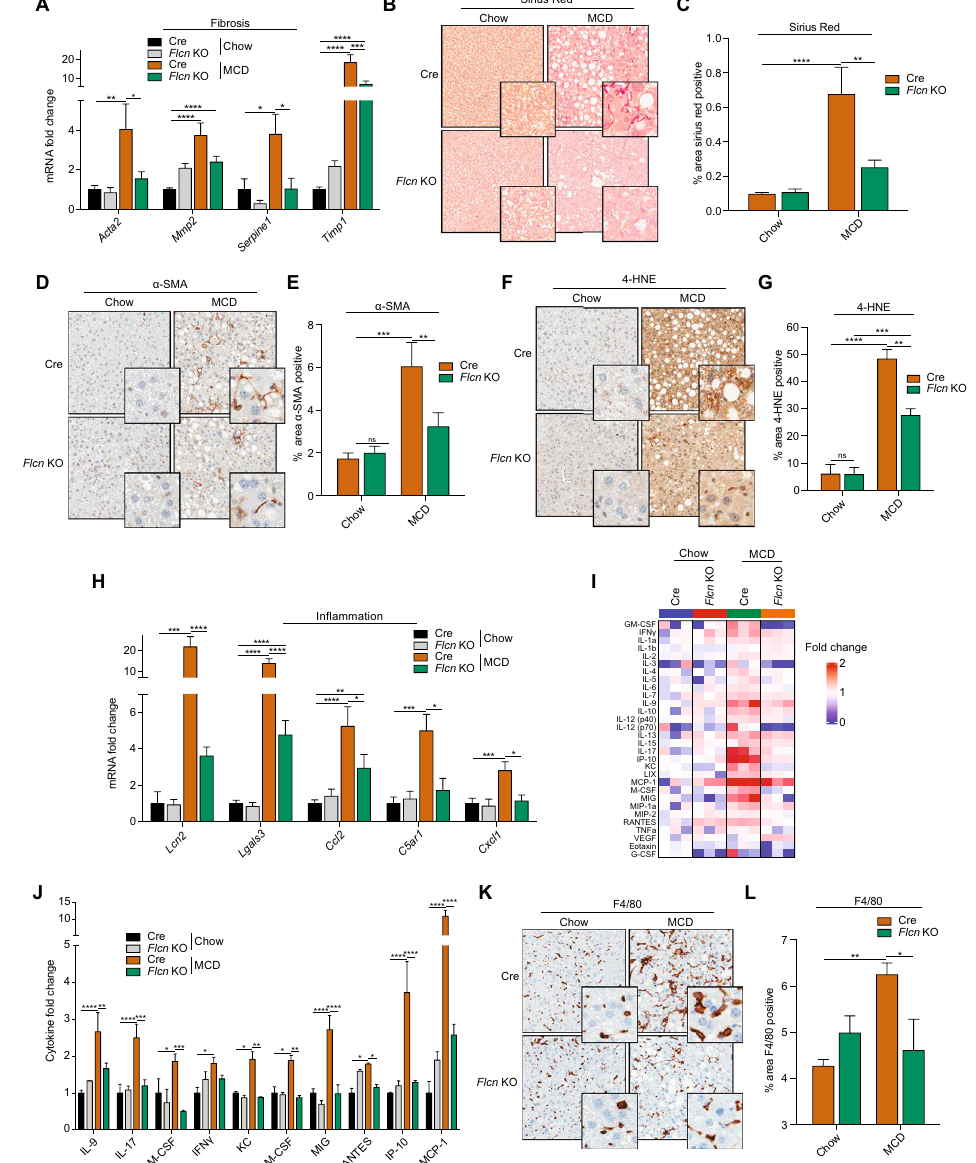
Figure 3. Flcn loss reduces MCD diet-induced fibrosis and inflammation. ( A ) Relative quantitative real ‐ time PCR analysis of fibrosis-related genes mRNA transcript levels in livers of mice fed either on chow or methionine/ choline deficient diet (MCD) over a period of 6 weeks (mean ± SEM of the RNA fold change of indicated mRNAs; two-way ANOVA, *P < 0.05, **P < 0.01, ***P < 0.001, ****P < 0.0001; n = 8 mice per condition). ( B ) Sirius red staining in liver sections of mice fed as described in ( A ). Images are representative of 6 mice per condition. ( C ) Quantification of the sirius staining in liver sections of mice fed as described in ( A ) (mean ± SEM, two- way ANOVA, **P < 0.01; ****P < 0.0001; n = 6 mice per condition). ( D ) α-SMA Immunohistochemistry (IHC) staining in liver sections of mice fed as described in ( A ). Data are representative of 4 mice per condition. ( E ) Quantification of α-SMA IHC staining in liver sections of mice fed as described in ( A ) (mean ± SEM, two-way ANOVA, **P < 0.01; ***P < 0.001; n = 4 mice per condition). ( F ) 4-HNE Immunohistochemistry (IHC) staining in liver sections of mice fed as described in ( A ). Data are representative of 4 mice per condition. ( G ) Quantification of 4-HNE IHC staining in liver sections of mice fed as described in ( A ) (mean ± SEM, two-way ANOVA, **P < 0.01; ***P < 0.001, ****p < 0.0001; n = 4 mice per condition). ( H ) Relative quantitative real ‐ time PCR analysis of inflammation-related genes mRNA transcript levels in livers of mice fed as described in ( A ) (mean ± SEM of the RNA fold change of indicated mRNAs; two-way ANOVA, *P < 0.05, **P < 0.01, ****P < 0.0001; n = 8 mice per condition). ( I-J ) Mouse cytokines and chemokines quantification in liver homogenates of mice fed as described in ( A ) (mean ± SEM, two-way ANOVA, *P < 0.05, **P < 0.01, ***P < 0.001, ****P < 0.0001; n = 3 mice per condition). ( K ) F4/80 Immunohistochemistry (IHC) staining in liver sections of mice fed as described in ( A ). Data are representative of 4 mice per condition. ( L ) Quantification of F4/80 IHC staining in liver sections of mice fed as described in ( A ) (mean ± SEM, two-way ANOVA, *P < 0.05; **P < 0.01; n = 4 mice per